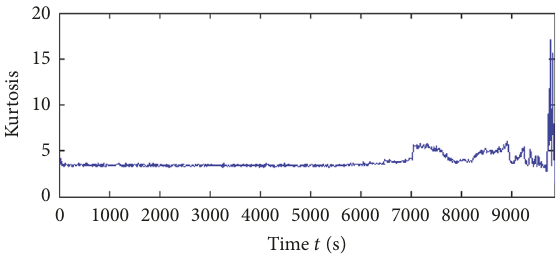
Figure 8: The kurtosis of bearing 1 for the whole life cycle.